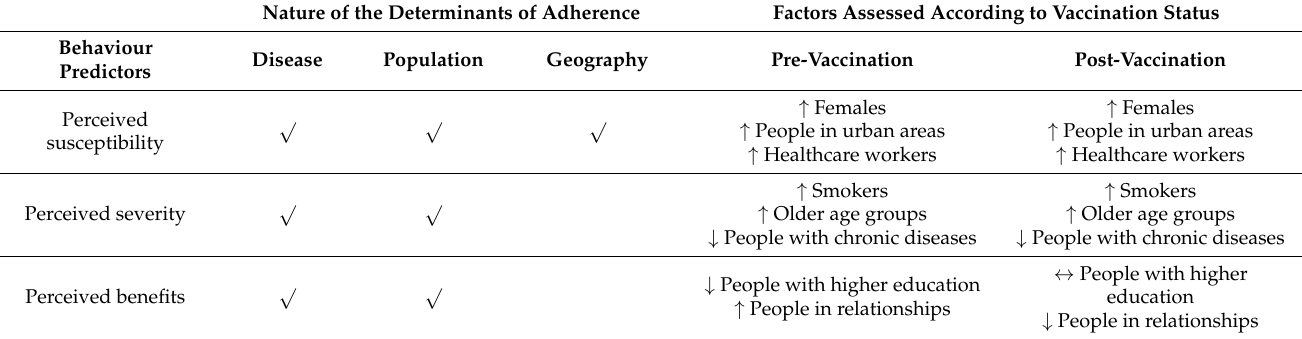
Table 4. Correlations among factors associated with adherence to personal protective measures against COVID-19 according to vaccination status and the health belief